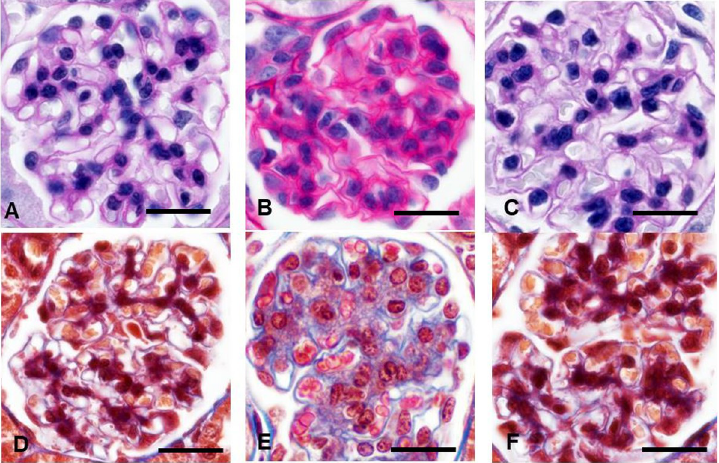
Fig 2. Representative images of hypertensive glomerulopathy in mouse models. A, D Normal mouse glomerulus. B, E Angiotensin II infused mice. Diminished glomeruli contain abundant mesangial cells, expanded mesangial matrix, and reduced capillary lumens. Prominent mesangial expansion has mild fibrotic component: Collagen staining increased along the glomerular basement membrane. C, F Glomeruli in the renin overexpressing mice appear unremarkable. Hyalinosis and focal segmental glomerulosclerosis was absent in both models. A-C –periodic acid- Schiff; D-F —Masson trichrome staining. x600.